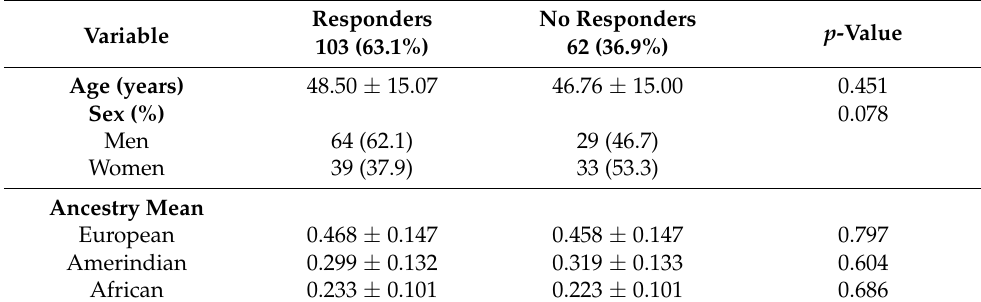
Table 1. Clinical and epidemiological variables of the investigated